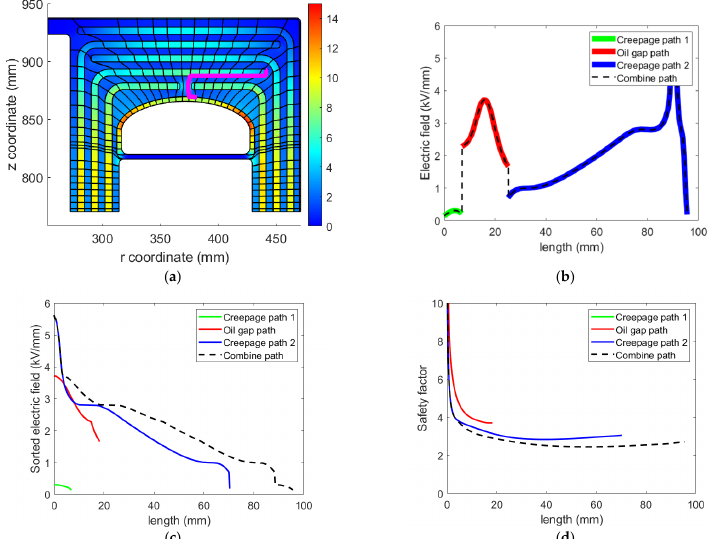
Figure 13. Extracting a combined path from an oil gap path and the linked creepage paths.